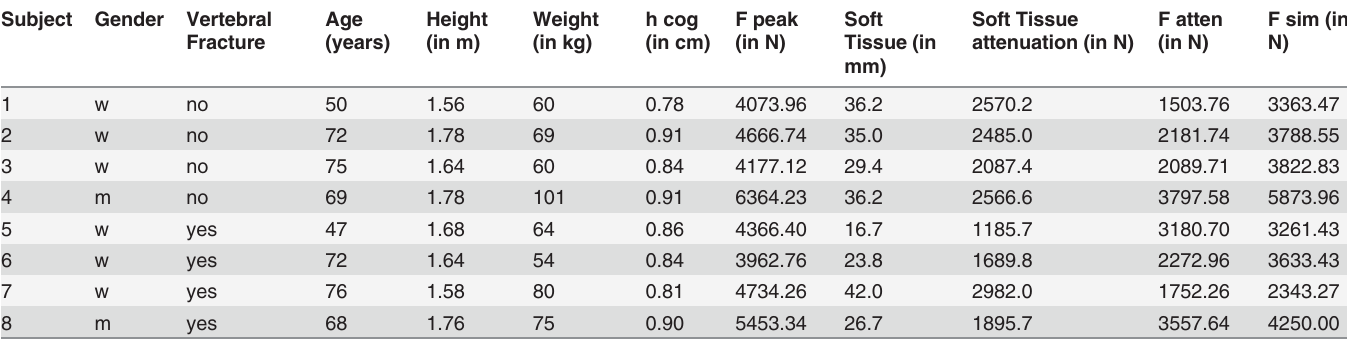
Table 1. Patient characteristics of the subjects from the fracture group and the control group and according force calculation values derived from the FEA simulations. Subject Gender Vertebral